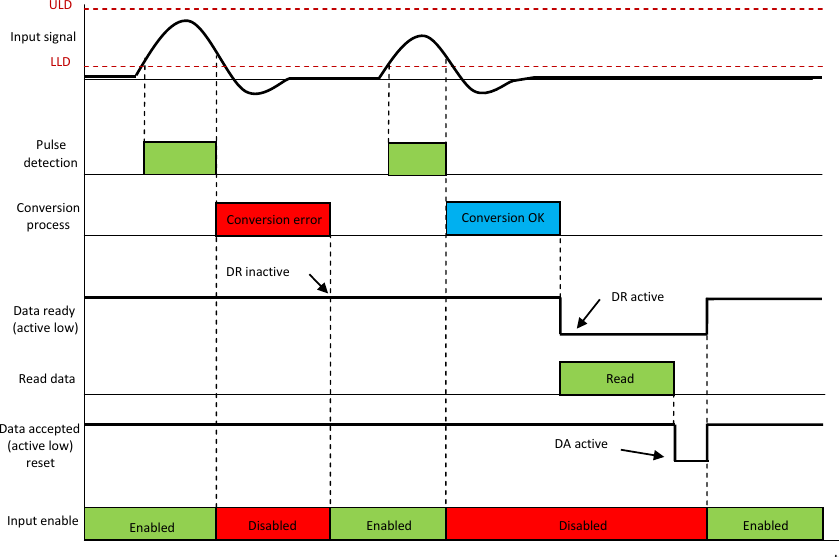
Figure 5. ADC conversion process. The ADC detects a peak when the input signal rises above the LLD threshold and below the ULD threshold. The detection process ends when the input pulse falls below 90% of its peak amplitude. In that moment, the signal input is disabled and the conversion process starts. If an error occurs in the conversion process, the DR signal remains inactive and the input signal enabled again. If the conversion process is OK, the DR is activated, and the Data Acquisition System reads the data and activates the DA signal, which causes the DA to go to inactive and the signal input to be enabled again.